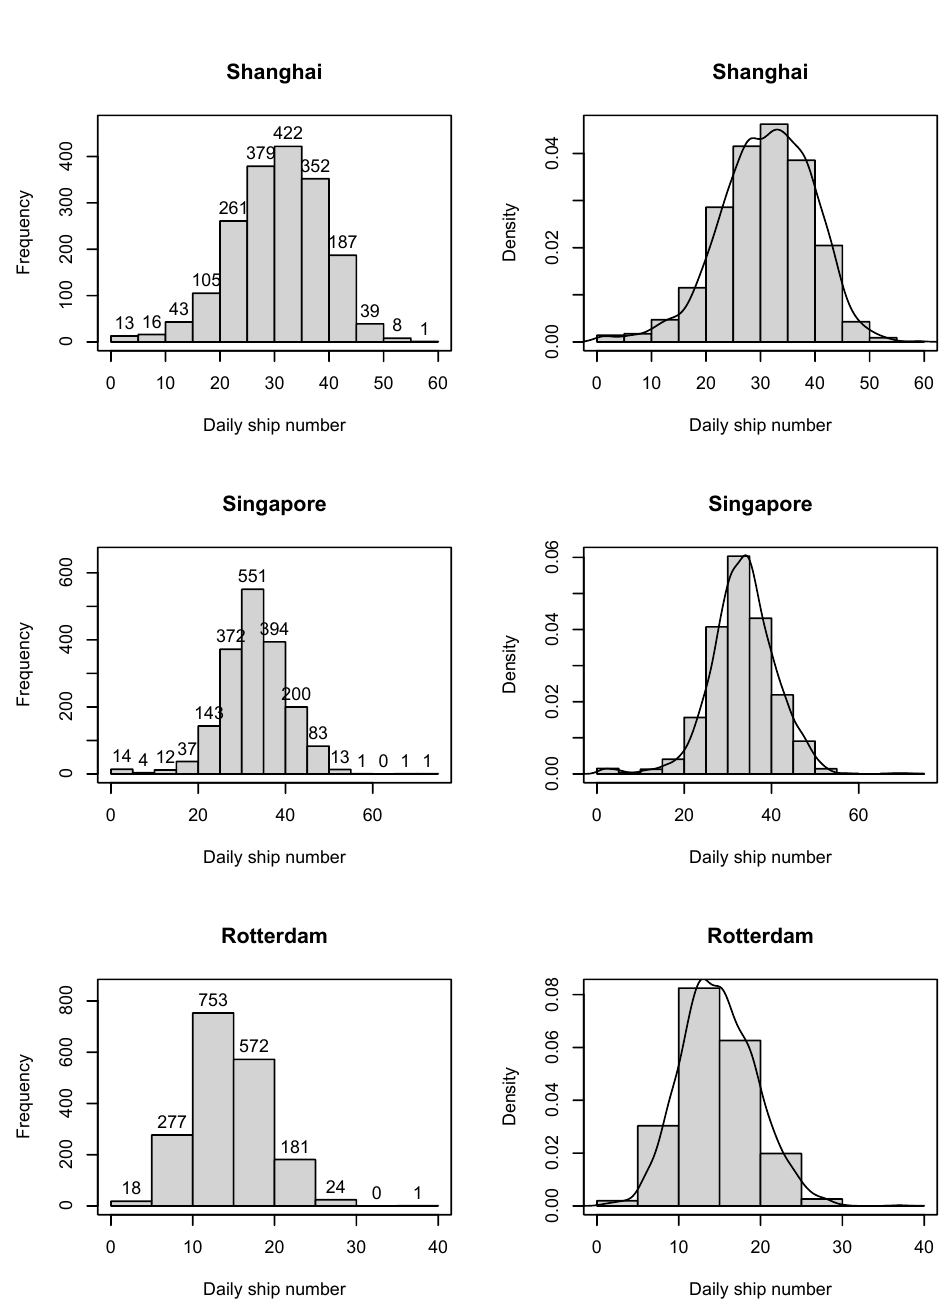
Figure 2. Frequency and probability density distribution of daily ship flow